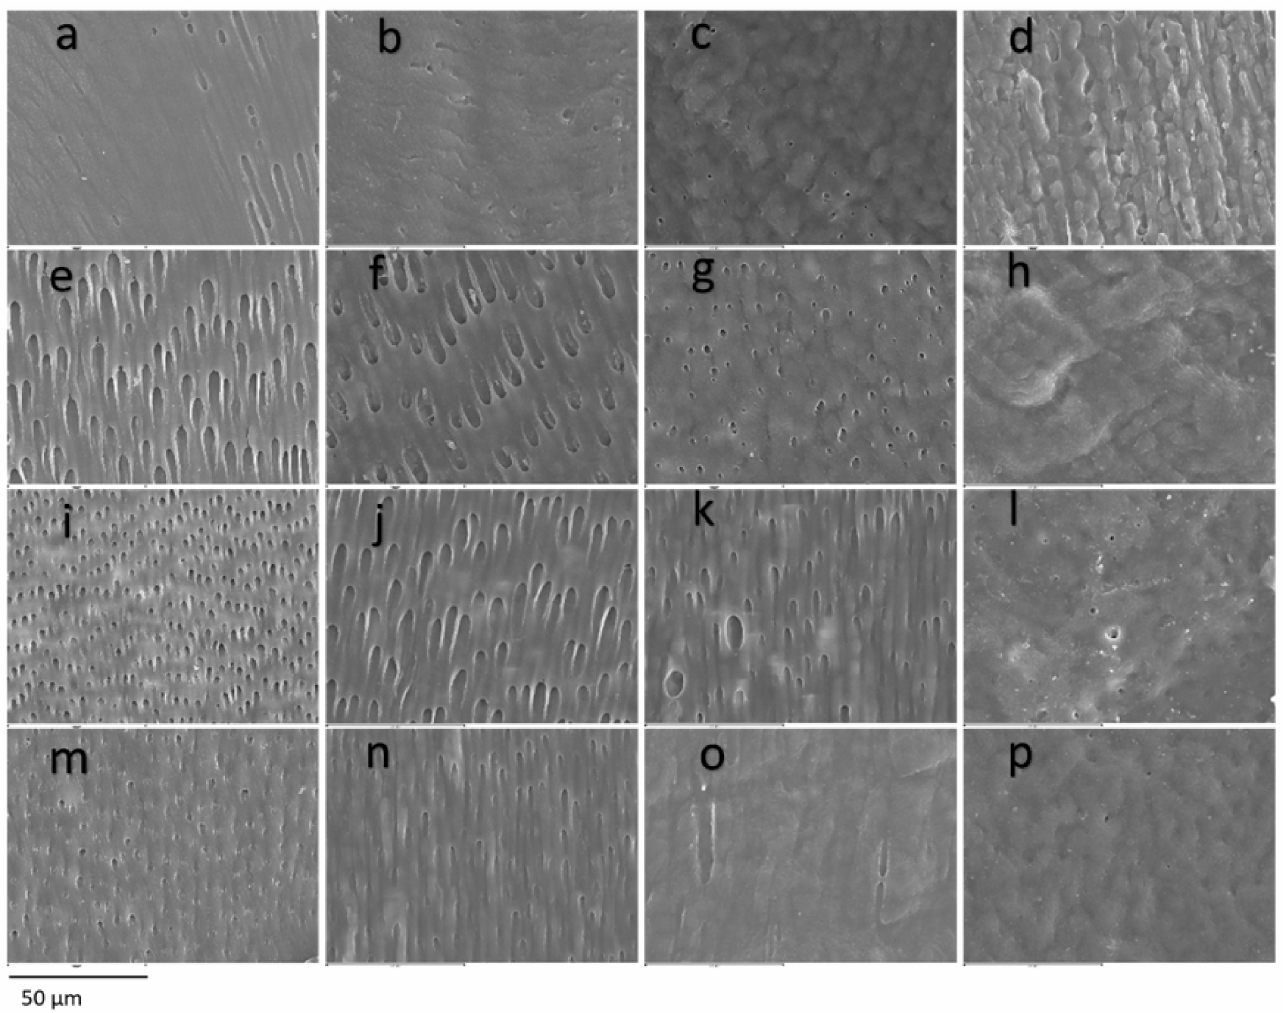
Figure 3. Dentin. SEM photomicrographs at original magnification of 1000 × . Superficial dentin ( a – d ) of a control tooth ( a ), dentin with mild involvement and alteration in the direction of the dentin tubules ( b ), dentin with moderate involvement, heterogeneity in the diameter and direction of the dentin tubules and cerebroid appearance ( c ) and severely affected dentin, atubular amorphous tissue with a cerebroid appearance ( d ). Middle dentin ( e – h ) of a control tooth ( e ) without affectation, with mild affectation ( f ) with heterogeneity in the diameters of the dentinal tubules, moderate with partial obliteration of the dentinal tubules ( g ) and severe affectation with the presence of amorphous atubular tissue ( h ). Deep dentin ( i – l ) of a control tooth ( i ) with homogeneity in direction and tubular diameter, mildly affected dentin ( j ) presenting slightly irregular diameters, moderately affected dentin ( k ) with the presence of giant tubules and heterogeneity in the diameter of the dentinal tubules and severely affected dentin ( l ) practically atubular and with an amorphous appearance. Pulpar dentin ( m – p ) of a control tooth ( m ) without alterations, of a tooth with slight alterations ( n ) with slight discrepancies in the tubular diameter, of a tooth with moderate alterations ( o ) with a decrease in the tubular pattern and of a tooth with severe alterations ( p ) with an atubular and cerebroid